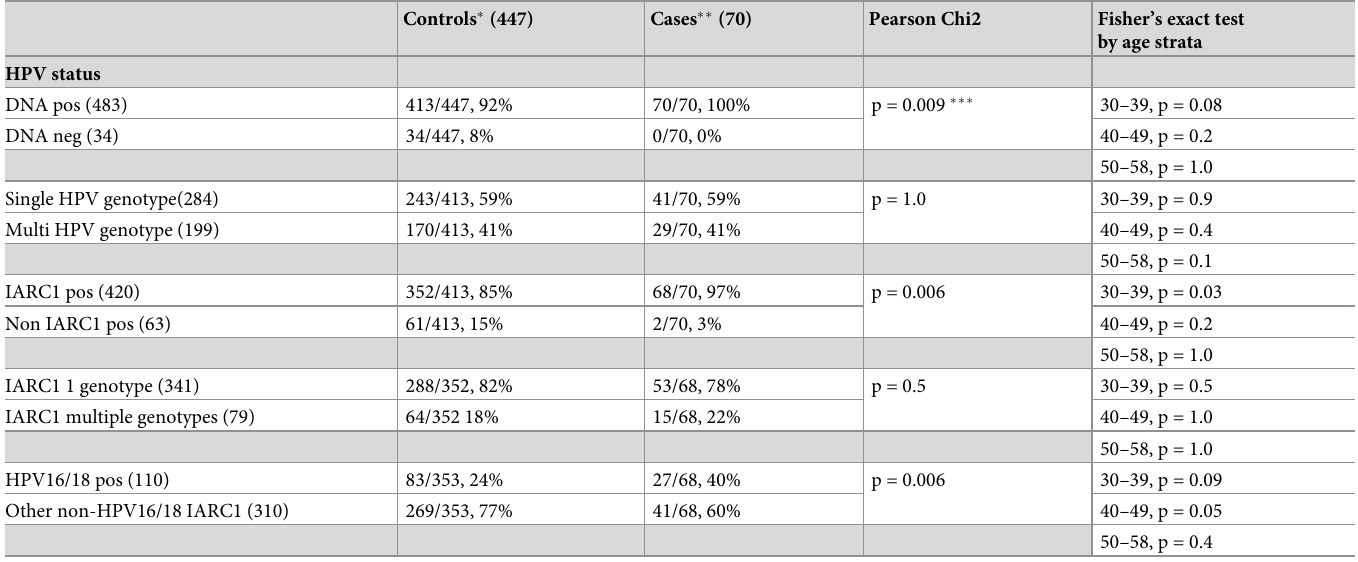
Table 1. HPV genotype distribution in groups of screening outcome. The HPV groups presented were positive vs. negative genotyping test, single vs. multiple geno- types within positive samples, positive for IARC1 genotype vs. positive for other non-IARC1 genotype, single vs. multiple IARC1 genotype within IARC1 positive samples, and HPV16/18 positive vs. positive for other IARC1 genotype. Results from statistical comparisons (Pearson Chi2) of proportions between the groups are presented in addition to strata analyses by age group in comparison of proportions between age groups (Fisher’s exact test). Total numbers of samples per category are presented in brackets by each